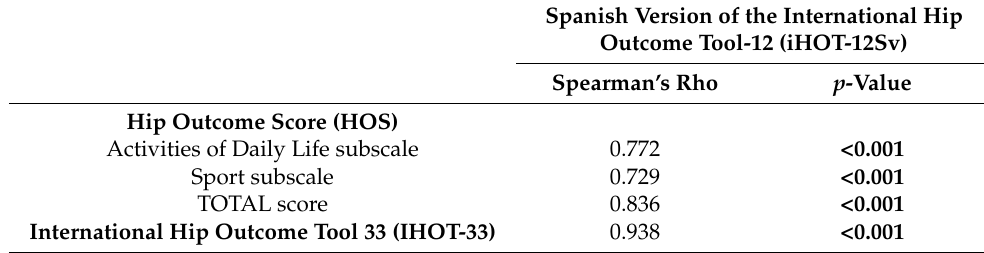
Table 2. Convergent validity of the Spanish version of the iHOT-12Sv.